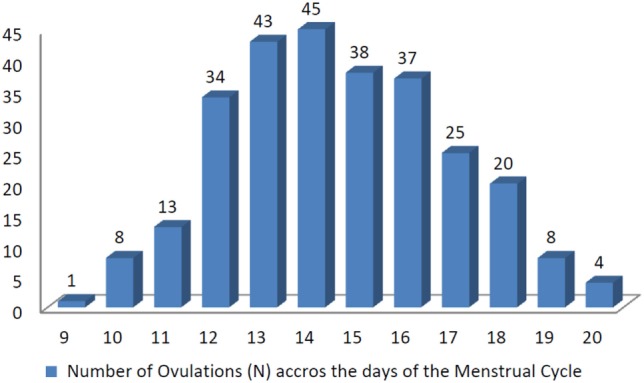
Number of ovulations (N) across the days of the menstrual cycle.